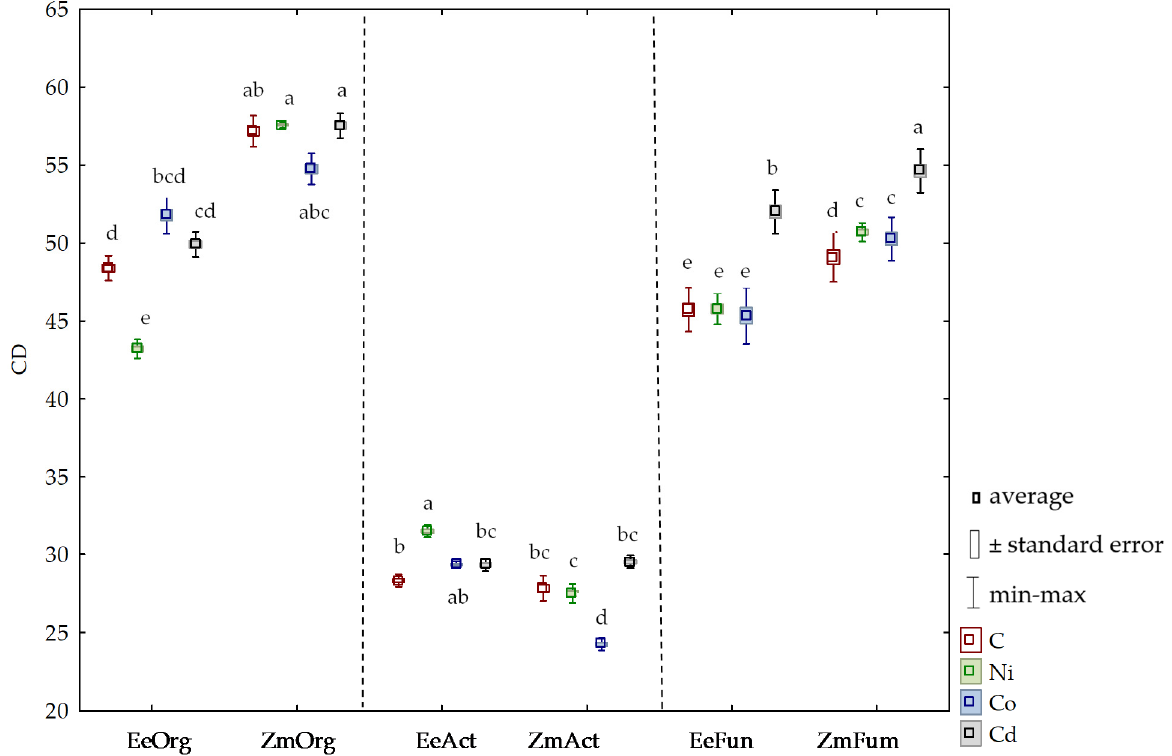
Figure 5. Microbial colony development index (CD) in the soil polluted with heavy metals and sown with Elymus elongatus L. and Zea mays L . Ee — Elymus elongatus L. ; Zm — Zea mays L. ; Org—organotrophic bacteria; Act—actinobacteria; Fun—fungi. For each group of microorganisms, the same letters (a–e) are assigned to the same homogeneous groups. The same letters for each group of microorganisms indicate no statistically significant differences.